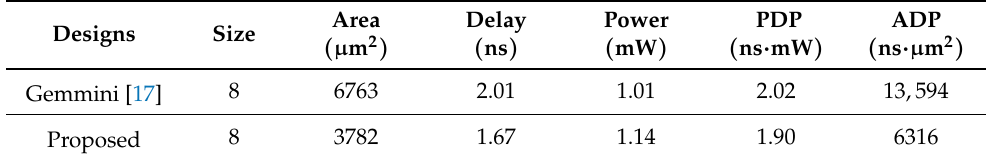
Table 1. Implementation results for 8 × 8 Gemmini [17] and the proposed CPA-Factored Gemmini processing elements (PEs).